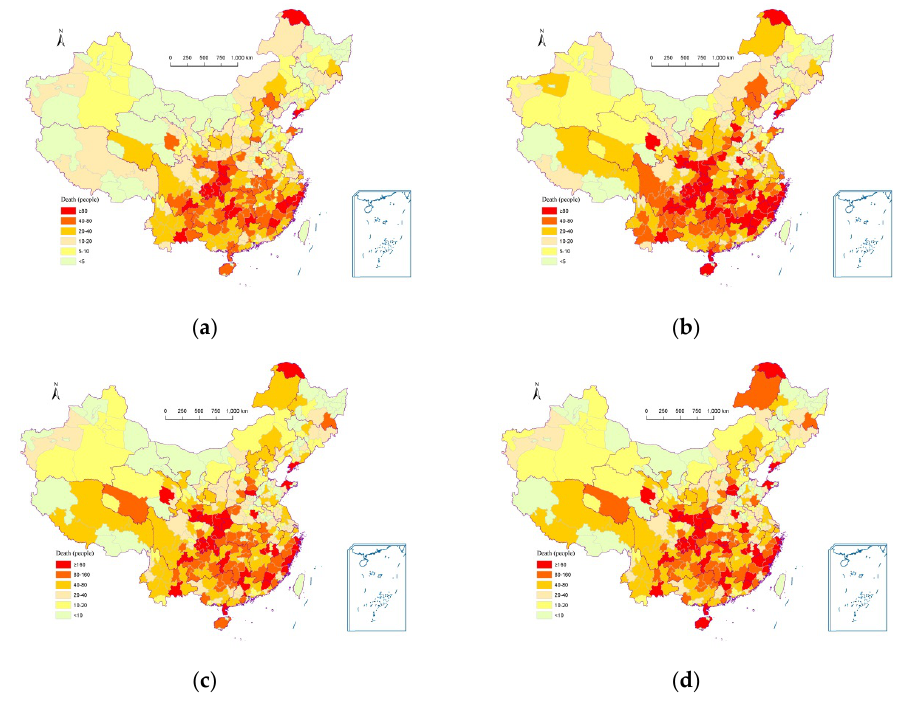
Figure 3. Casualty risks of multiple meteorological hazards with selected exceedance probabilities for each prefecture in China. ( a ) Annual exceedance probability of 10%; ( b ) Annual exceedance probability of 5%; ( c ) Annual exceedance probability of 2%; ( d ) Annual exceedance probability of 1%.